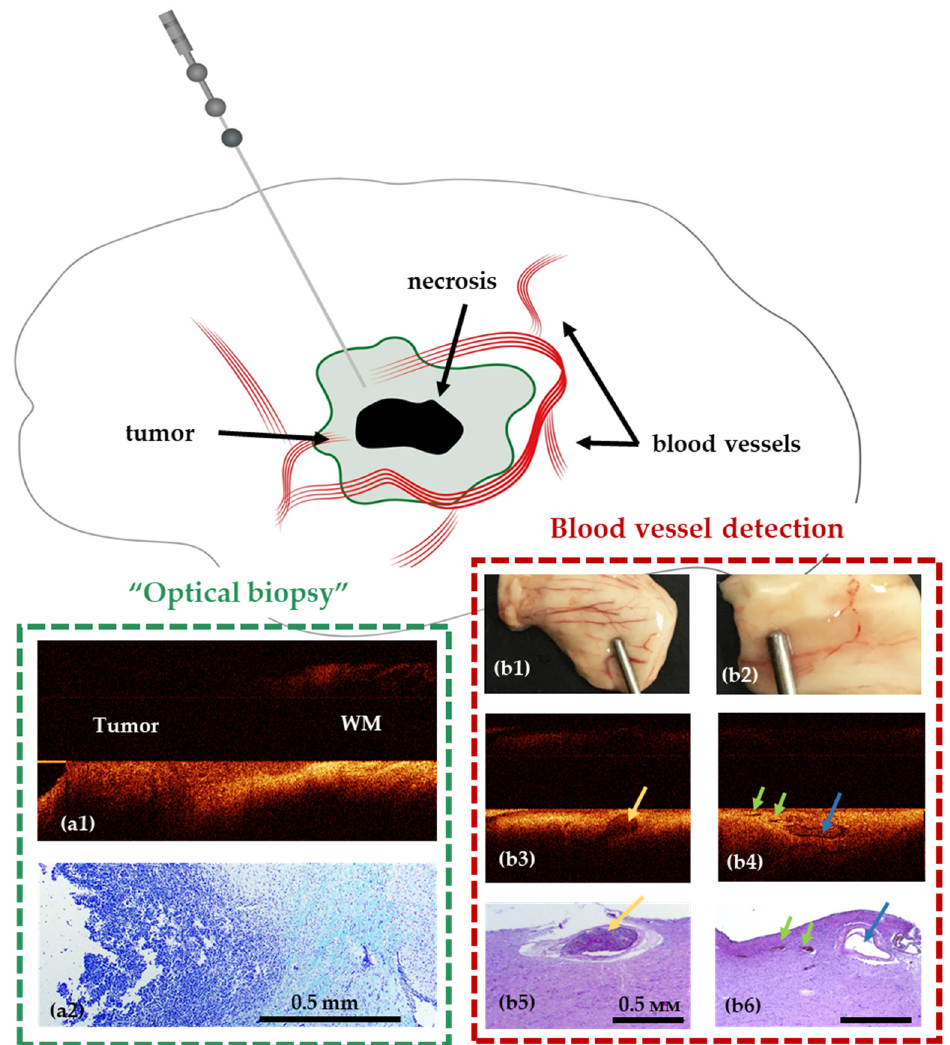
Figure 6. Use of stereotactic OCT needle for identification of tumor within white matter ( a1 , a2 ) and blood vessels ( b1 – b6 ) in preclinical studies. Visualization of white matter (WM)—tumor border using OCT in a model of glioblastoma 101.8 grafted into the rat brain and surrounding brain structures (frontal section) and corresponding histology ( a2 ). OCT visualization of blood vessels in normal human brain samples (post mortem samples); ( b1 , b2 )—digital photographs of the samples; ( b3 , b4 )—OCT images obtained using a needle system; ( b5 , b6 )—corresponding histological images. The width of the lumen of blood vessels, measured on histological preparations: 650 μ m ( b3 ), 300 μ m (blue arrow) and 125–150 μ m (green arrows) ( b4 ).